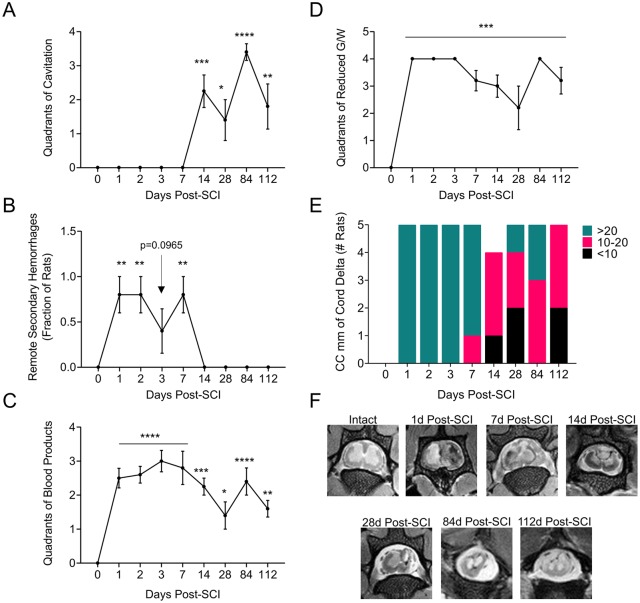
MRI analysis demonstrating disease progression.Cross sectional images recorded from spines, perfusion fixed in situ after euthanasia at each follow up time and analyzed blinded. A. Number of quadrants of cord with evidence of cavitation. 0 = none vs. 1–4 quadrants. B. Presence or absence of abnormality in a remote portion of cord, numbers of rats with evidence of remote damage. C. Number of cord quadrants with evidence of blood product. 0 = none vs. 1–4 quadrants. D. Number of cord quadrants with loss of grey/white contrast. 0 = none vs. 1–4 quadrants. E. Longitudinal extent of cord involvement (measured across multiple cord cross sectional images described a s length. 0 = none, 1-10mm, 11-20mm, >20mm. F. MRI images–cross sections taken at days 0, -r90r to injury, and 1, 2, 7, 14, 28, 84 and 112 days post balloon crush SCI. Measured changes demonstrate statistically significant changes in cord damage. ANOVA analysis *P < .05, **P < 0.01, ***P < 0.001, ****P < 0.0001.